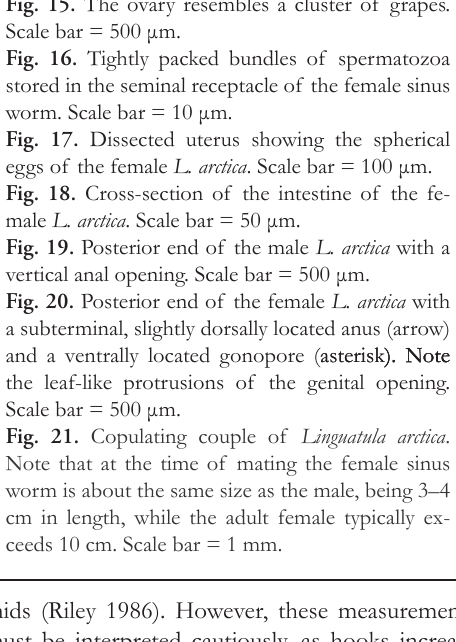
Fig. 15. The ovary resembles a cluster of grapes. Scale bar = 500 μm. Fig. 16. Tightly packed bundles of spermatozoa stored in the seminal receptacle of the female sinus worm. Scale bar = 10 μm. Fig. 17. Dissected uterus showing the spherical eggs of the female L. arctica . Scale bar = 100 μm. Fig. 18. Cross-section of the intestine of the fe- male L. arctica . Scale bar = 50 μm. Fig. 19. Posterior end of the male L. arctica with a vertical anal opening. Scale bar = 500 μm. Fig. 20. Posterior end of the female L. arctica with a subterminal, slightly dorsally located anus (arrow) and a ventrally located gonopore (asterisk). Noteasterisk). Note). Note the leaf-like protrusions of the genital opening. Scale bar = 500 μm. Fig. 21. Copulating couple of Linguatula arctica . Note that at the time of mating the female sinus worm is about the same size as the male, being – cm in length, while the adult female typically ex- ceeds 10 cm. Scale bar = 1